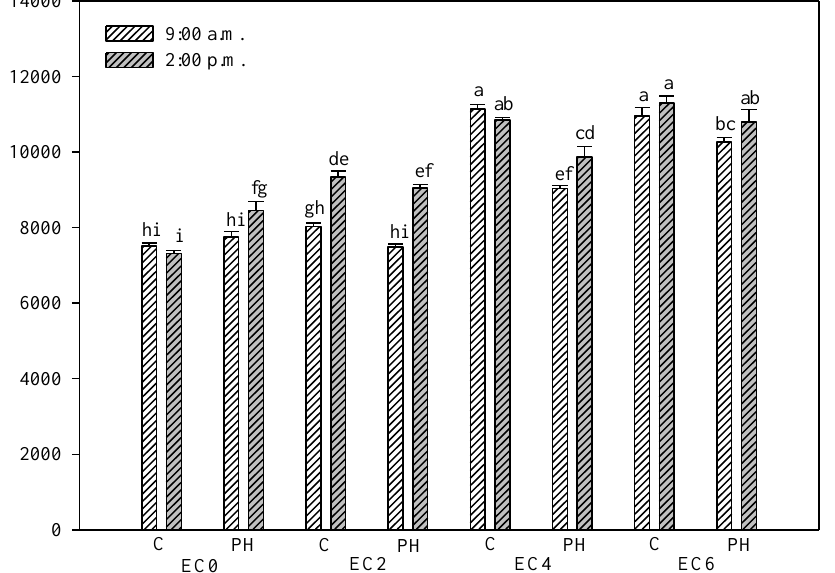
Figure 3. F0 (minimum fluorescence) of hemp leaves in the dark-adapted state (DAS) as affected by saline water irrigation (EC0 = non-saline water; EC2 = water at 2.0 dS m − 1 ; EC4 = water at 4.0 dS m − 1 ; EC6 = water at 6.0 dS m − 1 ) and biostimulant application (treated with a commercial legume-derived protein hydrolysate = PH and non-treated = C) recorded at 9:00 a.m. and at 2:00 p.m. Bars are means ± s.e. ( n = 10). Bars with different letters are significantly different according to the Duncan’s test with p ≤ 0.05.